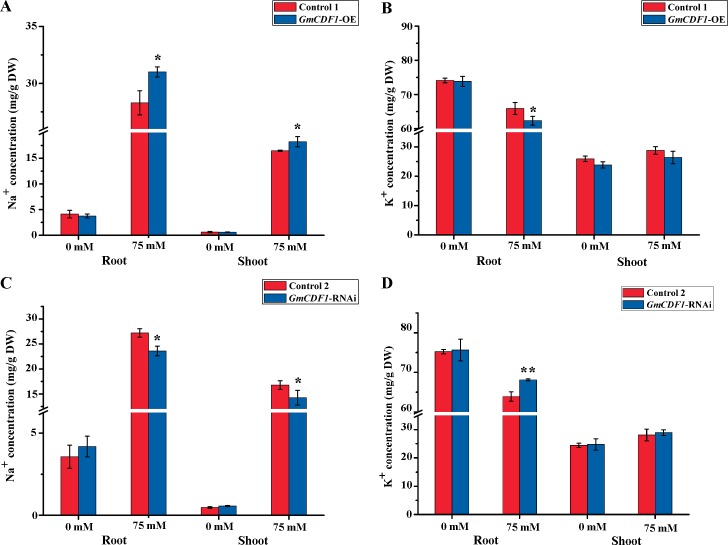
Distribution of Na+ and K+ in soybean hairy roots and shoots under salt stress.(A) Na+ contents of GmCDF1-OE hairy roots and their non–transgenic shoots compared with those of Control 1 plants after treatment with 0 mM or 75 mM NaCl for four days. The data are presented as the means±SEs (n≥5). (B) K+ contents of GmCDF1-OE hairy roots and their non–transgenic shoots compared with those of Control 1 plants after treatment with 0 mM or 75 mM NaCl for four days. The data are presented as the means±SEs (n≥5). (C) Na+ contents of GmCDF1-RNAi hairy roots and their non–transgenic shoots compared with those of Control 2 plants after treatment with 0 mM or 75 mM NaCl for four days. The data are presented as the means±SEs (n≥5). (D) K+ contents of GmCDF1-RNAi hairy roots and their non–transgenic shoots compared with those of Control 2 plants after treatment with 0 mM or 75 mM NaCl for four days. The data are presented as the means±SEs (n≥5). Statistical significance was detected by a two-tailed t-test. (*P<0.05, **P<0.01).